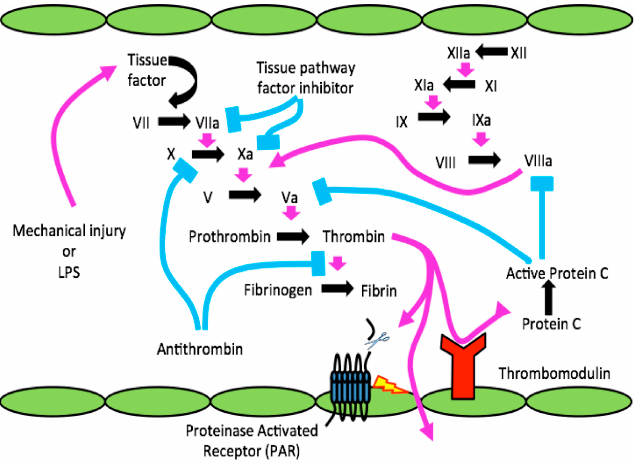
Figure 1. The clotting cascade activated by injury or infection (e.g., by LPS) and the blood–brain barrier (BBB). Schematic showing infection, LPS, or injury-releasing tissue factor (TF) to activate clotting, resulting in active α -thrombin, which cleaves PAR1 in endothelial cells (ECs) to disrupt the BBB. Through disrupted BBB, α -thrombin gains access to the CNS, where it can cleavage-activate the PARs on microglia or astrocytes, promoting neuroinflammation and potentially forming neurodegenerative lesions (modified from Festoff and Citron, 2019 [24]).